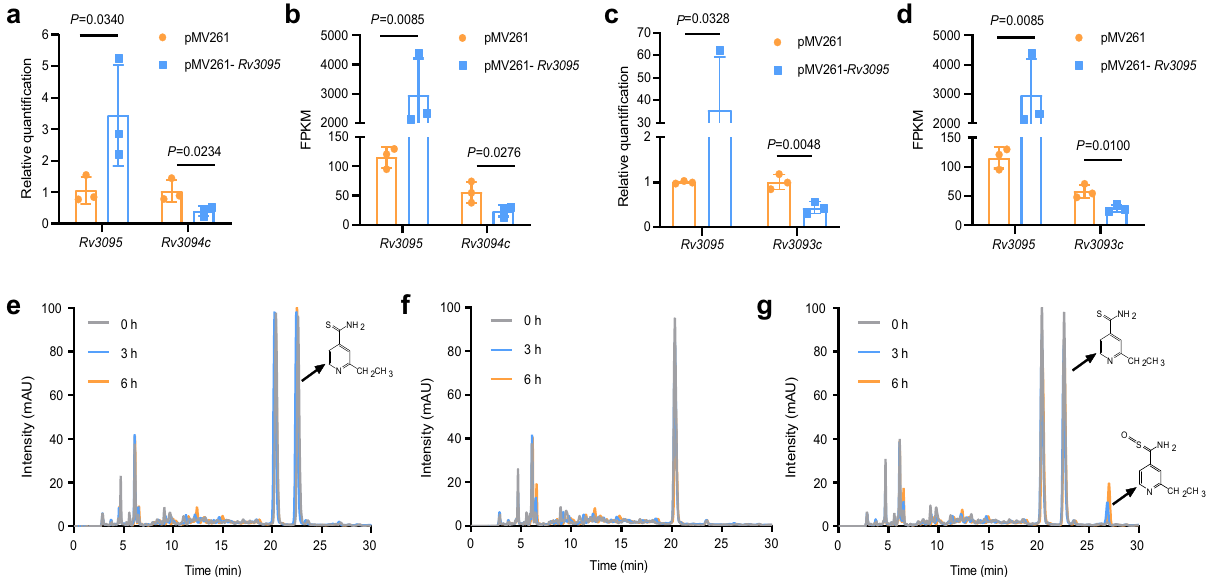
Fig. 4 Gene pair Rv3094c-Rv3095 is associated with ethionamide metabolism. a – d Analysis of Rv3094c ( a , b ) and Rv3093c ( c , d ) expression in M. tuberculosis H37Ra overexpressing Rv3095. a , c Relative quanti fi cation by qPCR. Error bars indicate standard deviation. One-tailed Student ’ s t -tests were performed. b , d RNA-seq analysis. Error bars indicate standard deviation. Student ’ s t -tests were one-tailed. Control: H37Ra containing an empty pMV261 vector. n = 3 biologically independent experiments. P = <0.05 was considered signi fi cant. e – g Representative HPLC-UV spectra for E. coli BL21 harboring an empty pET28a vector incubated with 100 μ g/ml ETH ( e ), E. coli BL21 harboring pET28a-Rv3094c in the absence of ETH ( f ), and E. coli BL21